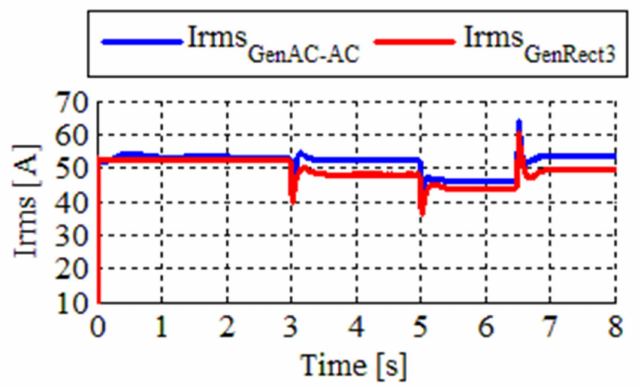
Figure 10. Root mean square (RMS) current delivery by the alternator.